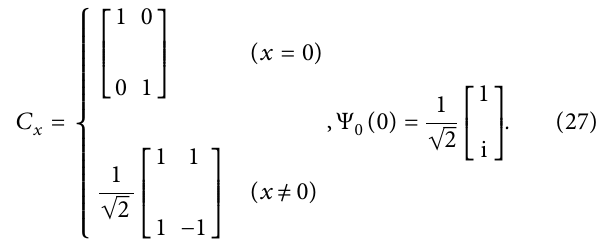
Figure 1: Transition of the distribution ] q ( x ) from each set ( n,x ) , respectively. Values on each coordinate ( n,x ) represent the corresponding value of ] ( x ) . For the coordinates that n do not have any display about ] n ( x ) , their values are